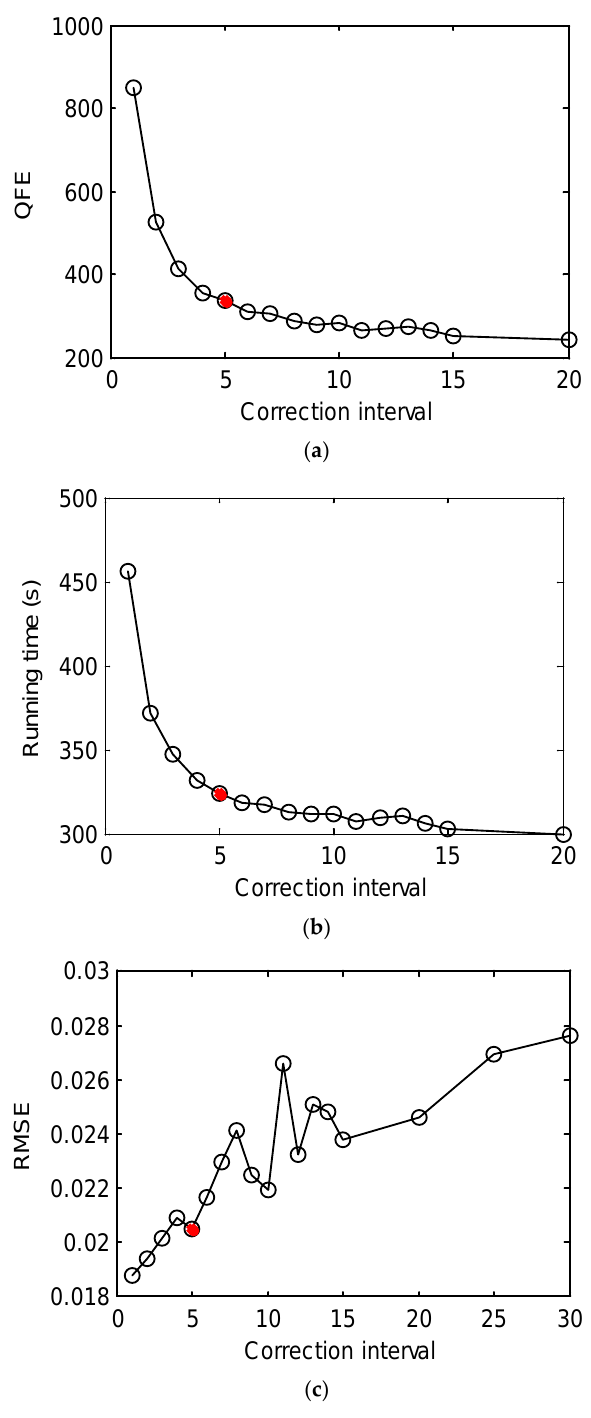
Figure 13. Fault diagnosis with different correction intervals of PLS under fault 7 with respect to ( a ) quantity of function evaluations (QFE); ( b ) the running time; ( c ) the root mean square error (RMSE).